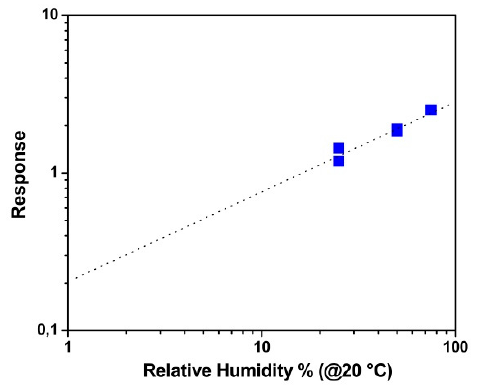
Figure 6. Dynamic sensor responses of bare SnO 2 and chitosan@SnO 2 hybrid NWs in the dark ( a ) and under UV light irradiation ( b ).